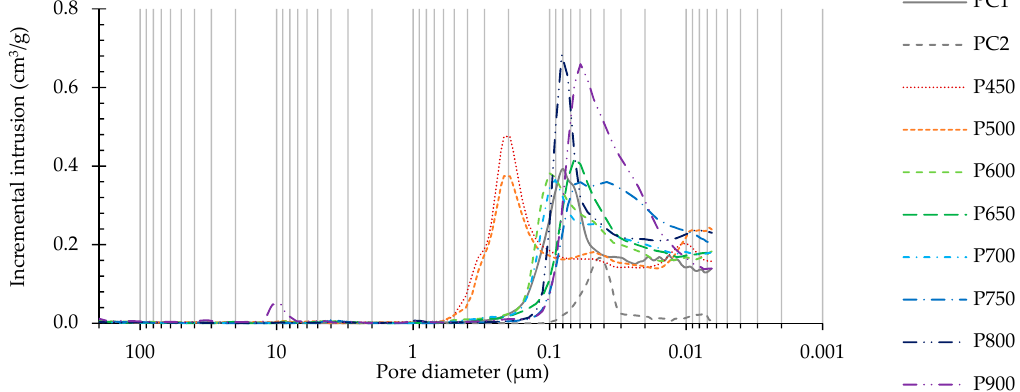
Figure 15. Cumulative pore volume as a function of pore diameter of PC1, PC2 and RC pastes at 28 days.